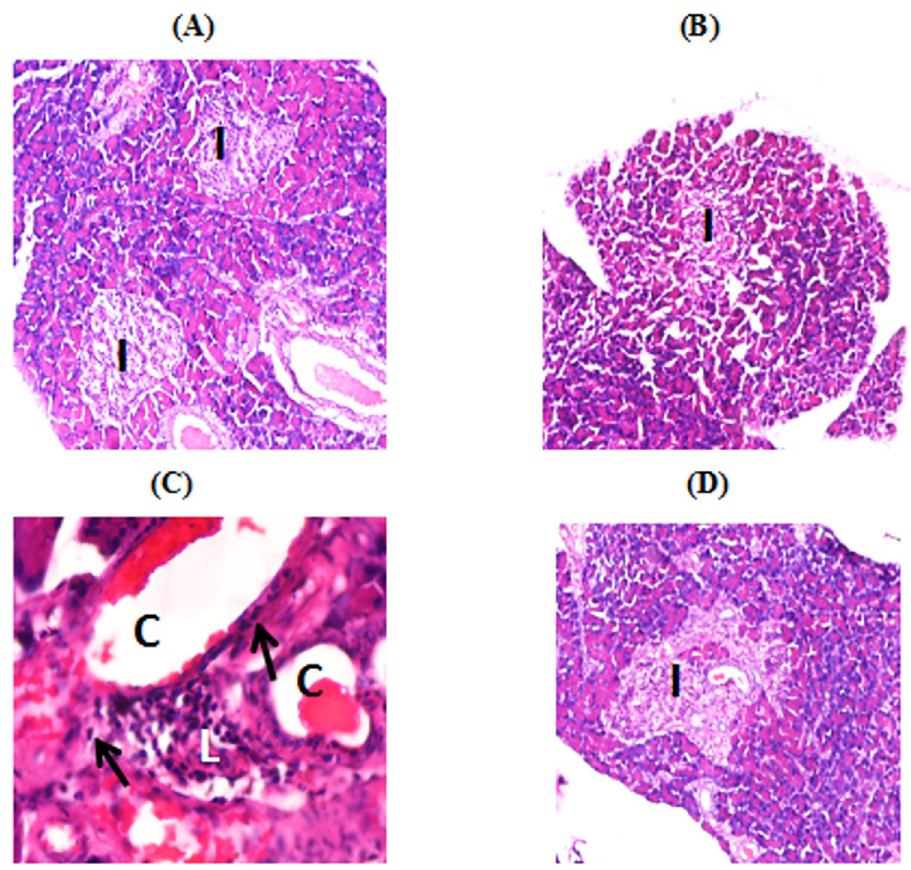
Fig 5. Micrographs of pancreatic tissues of different groups of rabbits. ( A ) Control rabbit pancreas showing normal appearance with islet with a central core of beta cells (I) enveloped by a peripheral, largely continuous mantle of non beta cells. Haematoxylin & Eosin x 10X. ( B&C ) Diabetic group pancreatic tissues showing congestion (C), fibrosis ( " ) and perivascular infiltration of lymphocytes (L) and decreased pale islet cells (I). Haematoxylin & Eosin x 10X. ( D ) Aminoguanidine treated diabetic rabbits showing near normal appearance of islet with a central core of beta cells (I). Haematoxylin & Eosin x 10X.